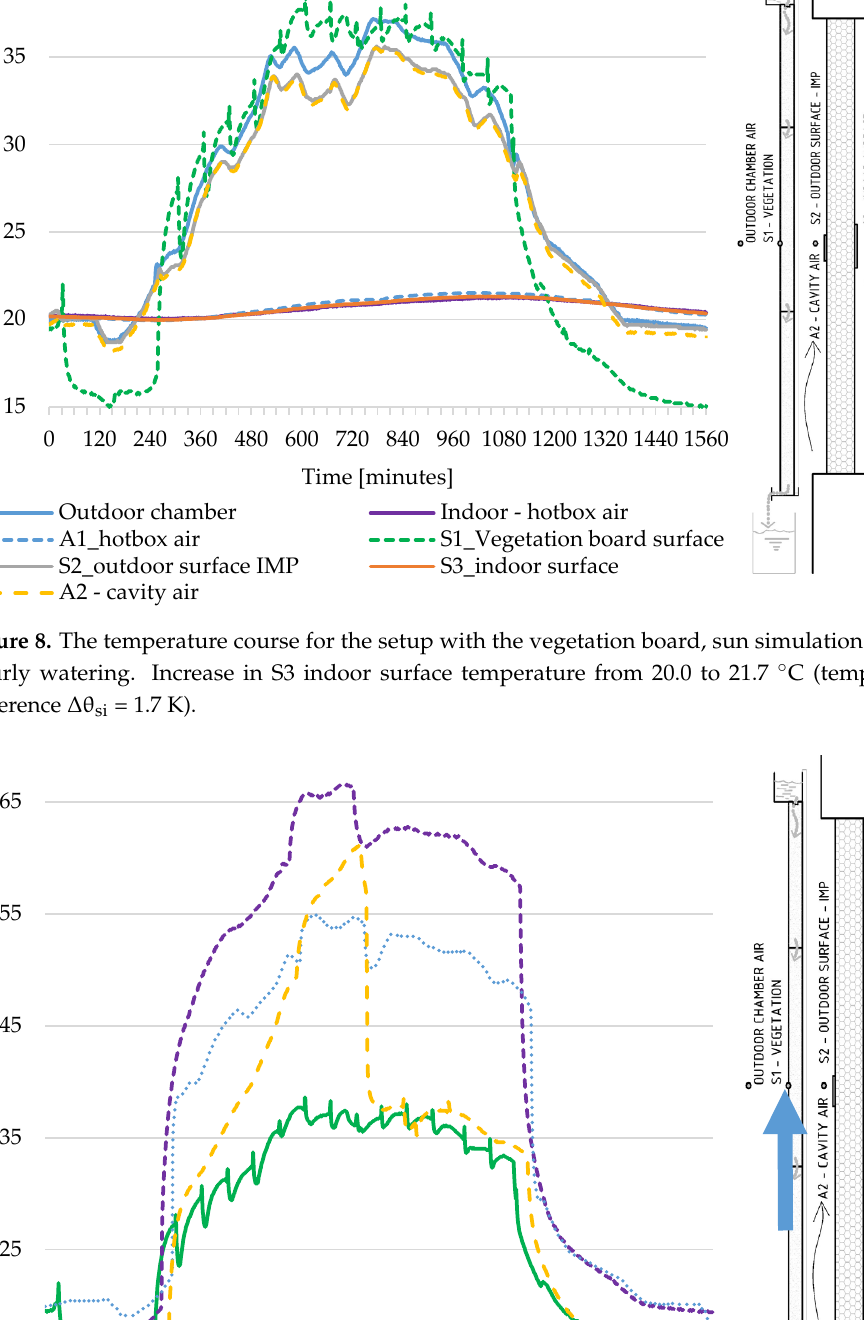
Figure 7. The temperature course for the setup with the vegetation board. 1 × watering after 12 h from start. Increase in S3 indoor surface temperature from 20.0 to 21.3 °C (temperature difference Δθ si = 1.3 K).